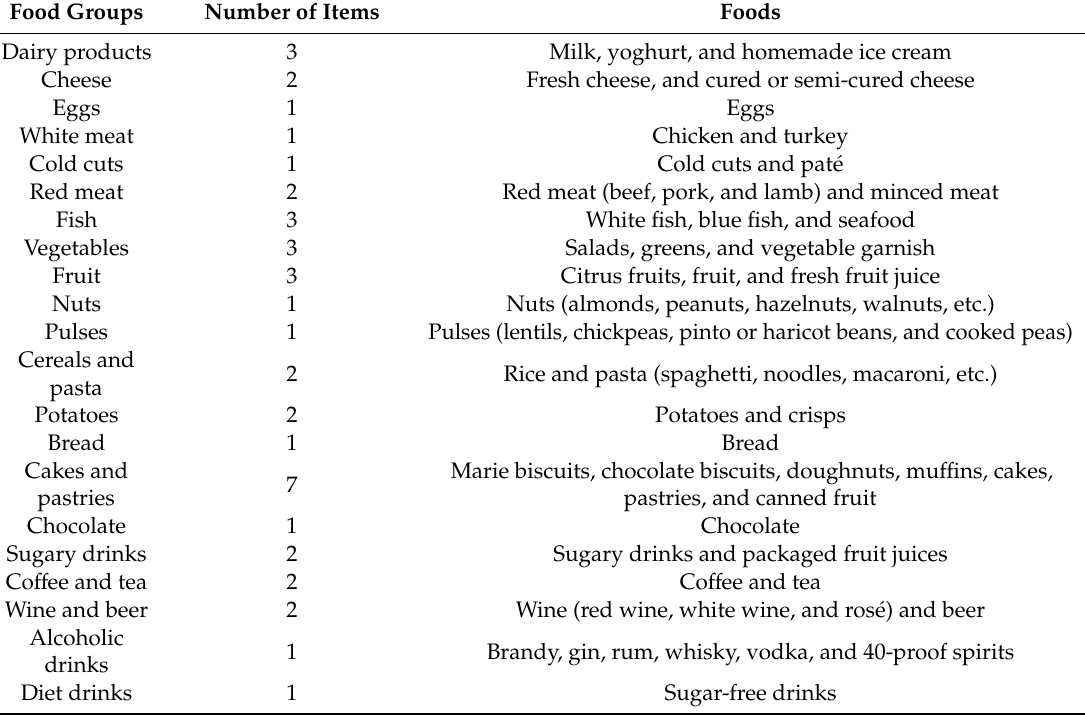
Table 1. Description of the food